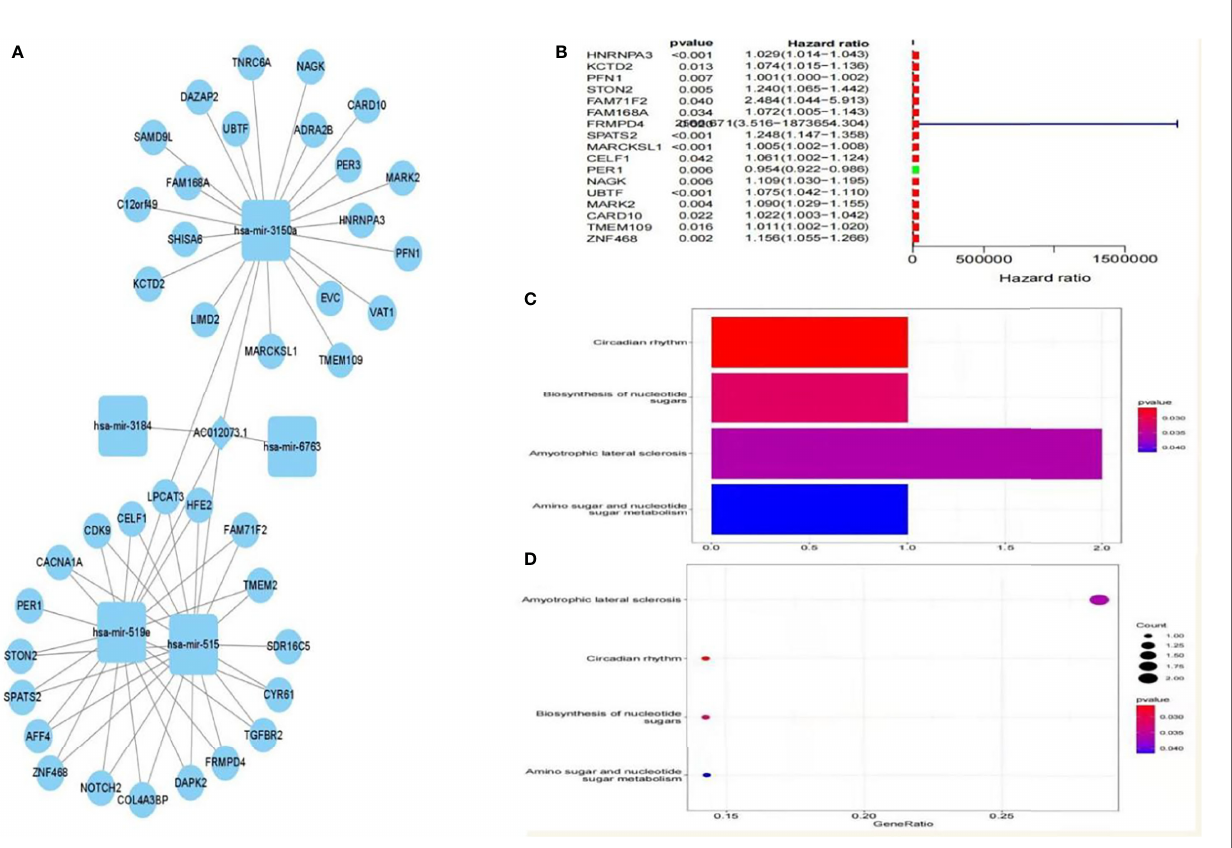
FIGURE 8 | Prognosis-related downstream target gene screening and enrichment analysis. (A) ceRNA interaction regulatory network based on AC012073.1, (B) Forest plot of prognosis-related downstream genes, (C) Bar graph of the results of KEGG enrichment analysis of prognosis-related downstream genes, (D) Bubble plot of KEGG enrichment analysis results of prognosis-related downstream